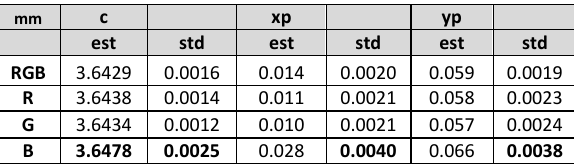
Table 2. Calibration parameters (c, xp, yp) for the individual calibrations using the GB camera (1st repeat) independent adjustment. All units in mm. The largest standard deviation